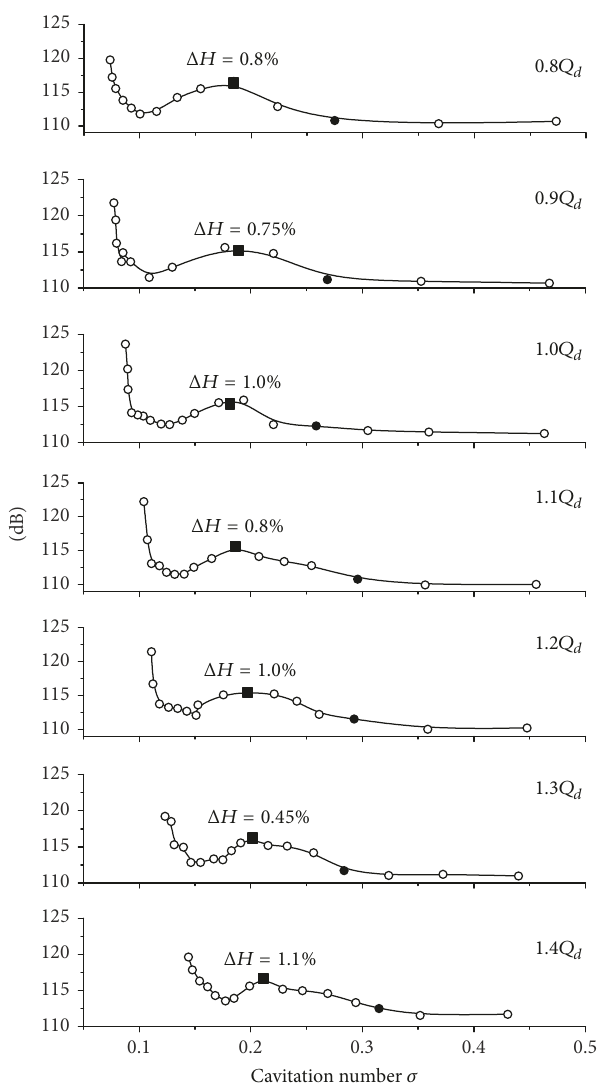
Figure 10: RMS values in 10–500 Hz frequency band versus cavita- tion number along 𝑦 direction of V 1 under various flow rates.